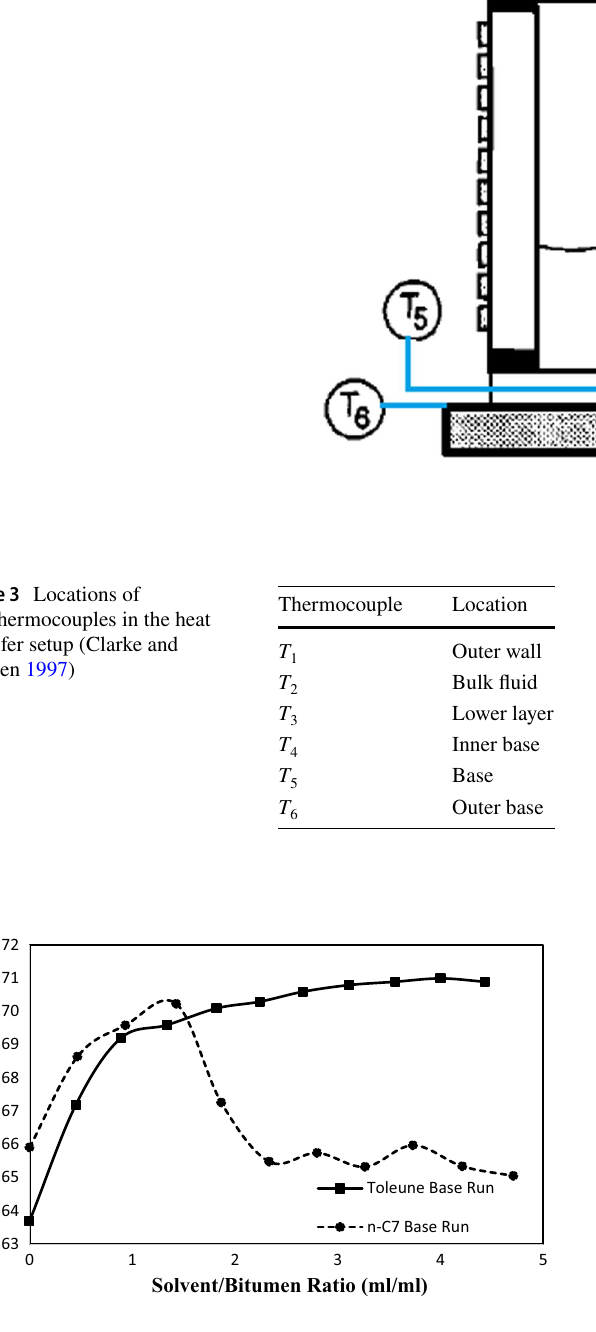
Fig. 19 Temperature of the cell bottom in the presence of toluene and n -heptane (Clarke and Pruden